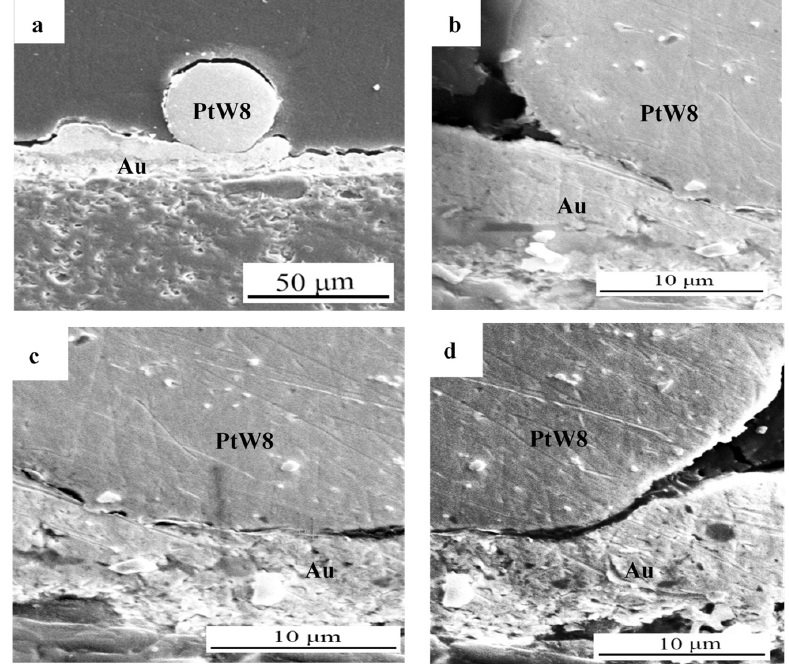
Figure 6. ( a ) SEM cross-sectional images of joints, ( b ) enlarged view on the left side of the cross- section, ( c ) middle enlarged view of cross-section, and ( d ) enlarged view on the right side of the cross- section.